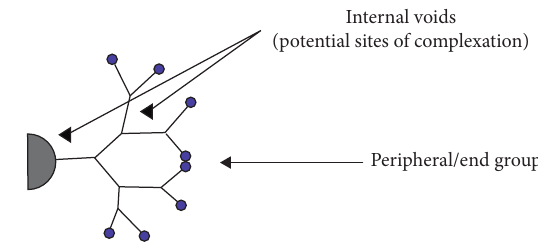
Figure 1: Three main parts of a